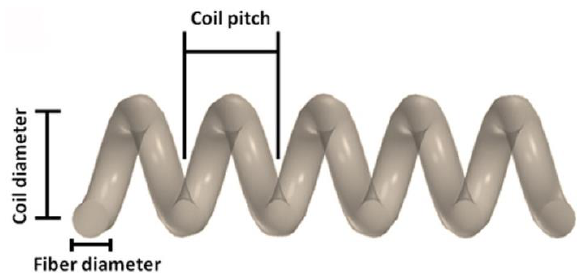
Figure 3. Schematic illustration for fiber diameter, coil diameter, and coil pitch ([16], Shaikjee and Coville,